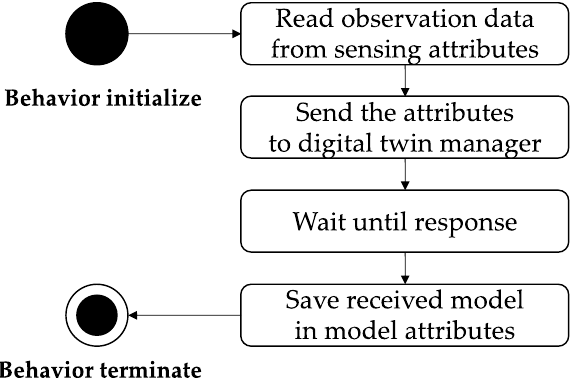
Figure 3. The sequence diagram for identifying behavior.